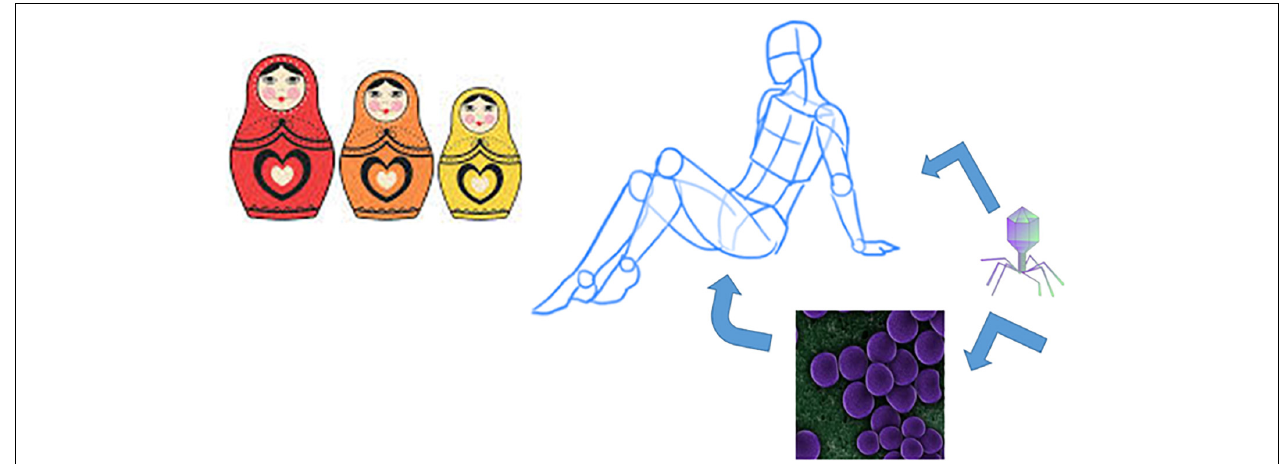
FIGURE 5 | Russian doll model for the multilevel relationships phage–bacteria–human